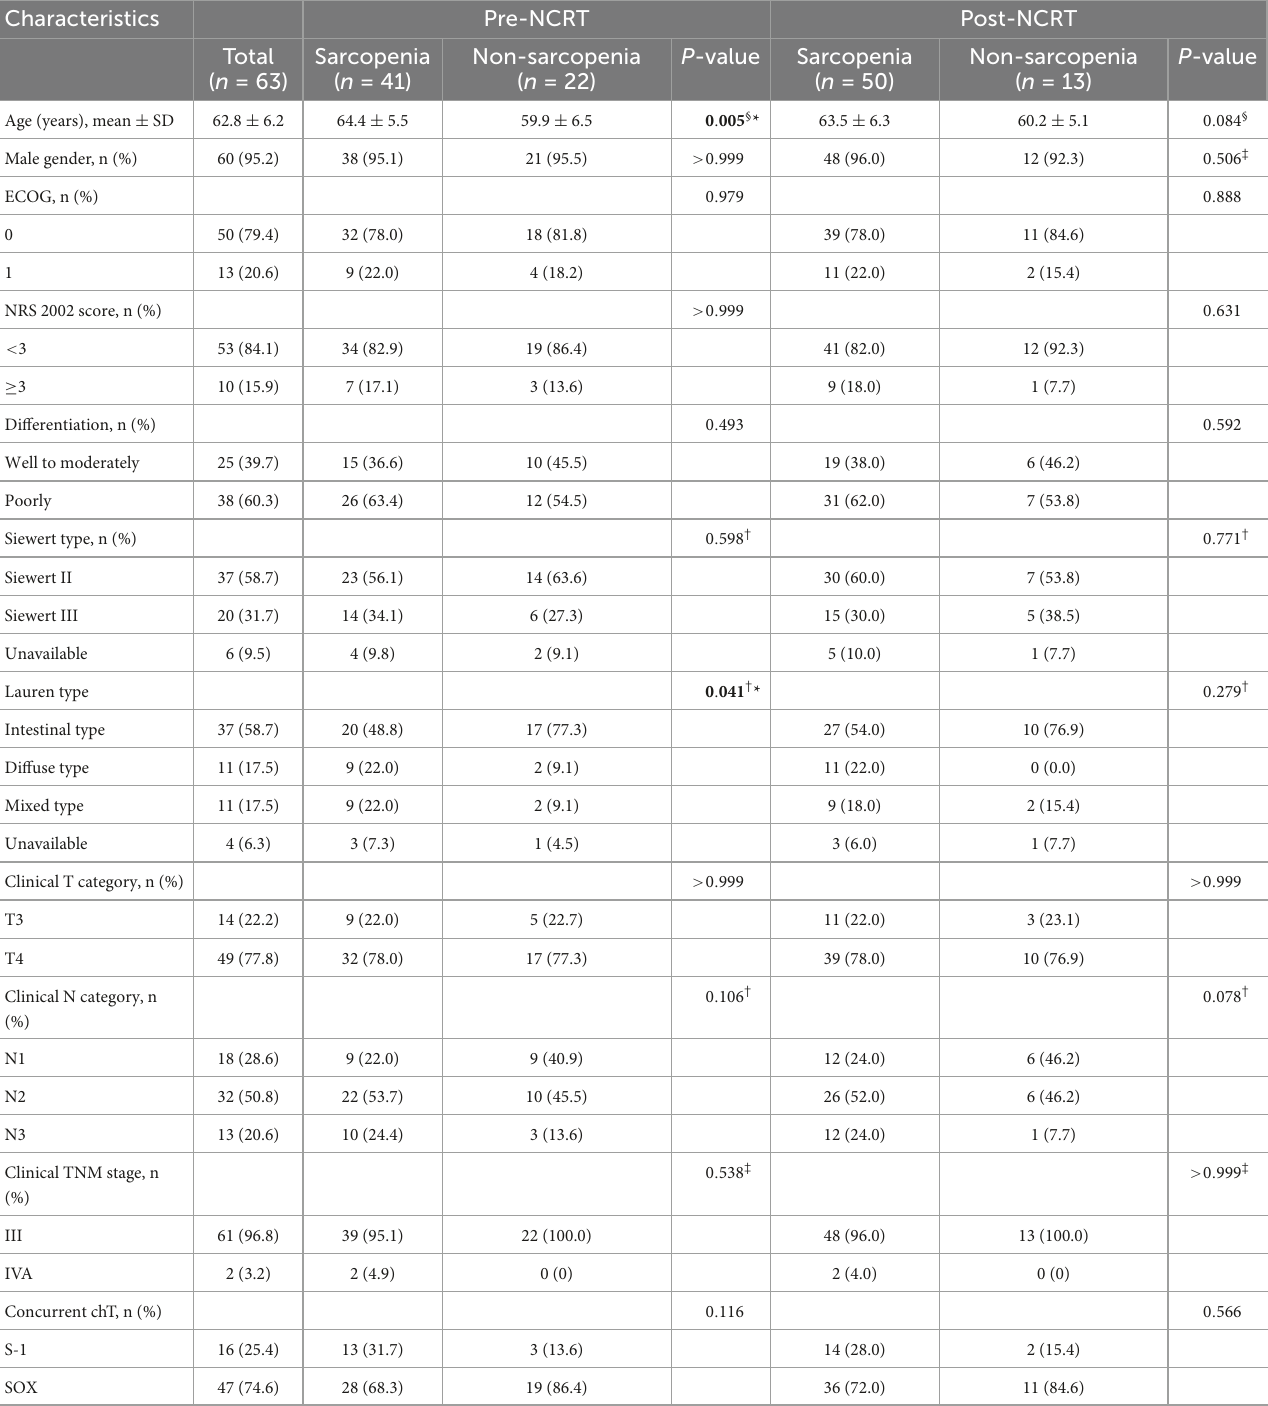
TABLE 1 Clinicopathological characteristics of patients according to pre- and post-NCRT sarcopenic status ( n = 63).